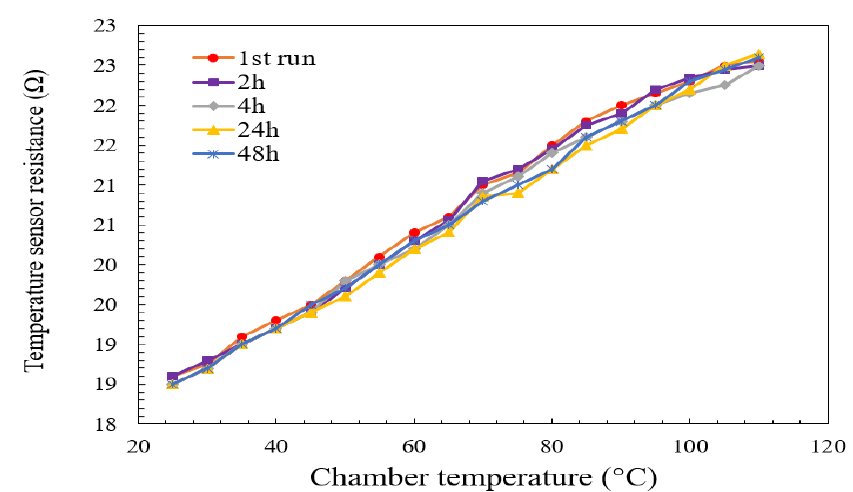
Figure 19. Constant measurement on the temperature sensor resistance versus chamber temperature at 60%